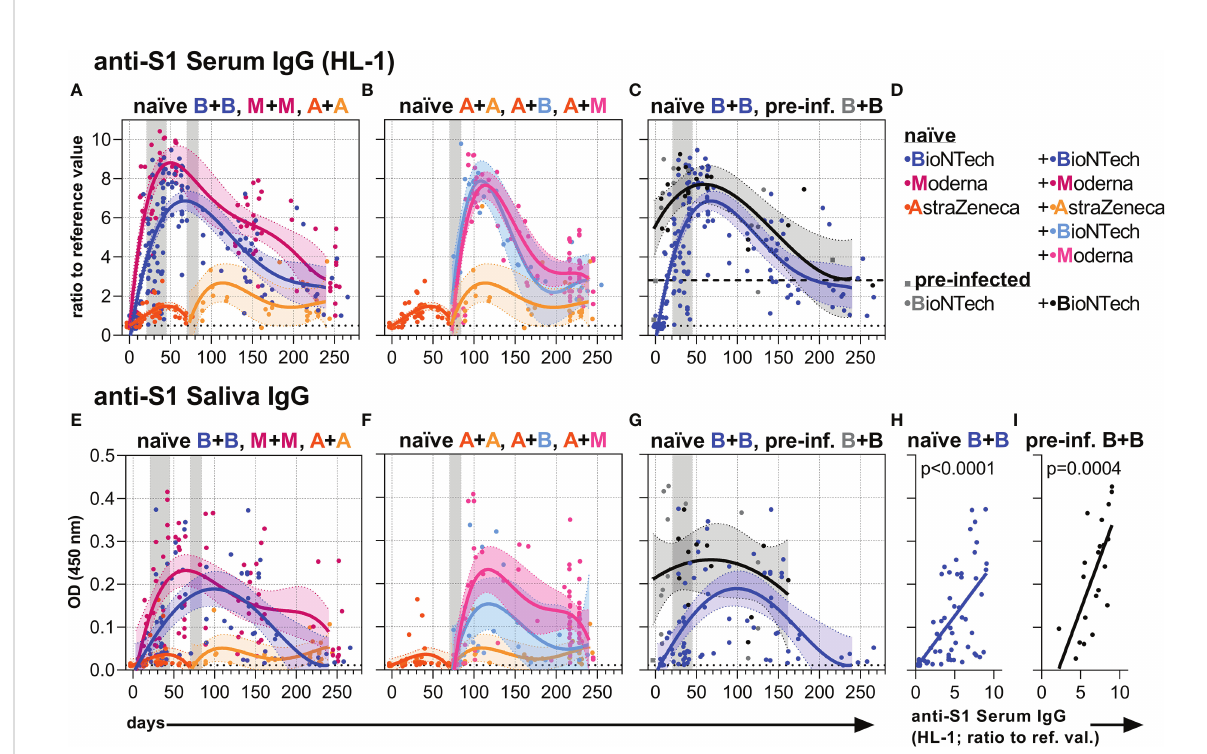
FIGURE 1 Anti-S1 serum and salivary IgG levels. (A-C) Anti-S1 serum IgG (HL-1 ELISA) levels (ratios to reference value) of the indicated six vaccination groups. (D) Color legend of the six study groups. (E – G) Anti-S1 salivary IgG levels (OD 450 nm values) of the indicated six groups. Gray bars: time windows of the second shot after the fi rst shot with an mRNA (between day 21 and 45) or adenovirus-based (between day 70 and 84) vaccine. Dashed ( — (C) ) and dotted ( … ) lines indicate the corresponding average anti-S1 IgG levels of pre-infected individuals without/before vaccination or non-vaccinated healthy (negative) controls, respectively. (H, I) Pearson correlations between anti-S1 serum IgG (HL-1) levels and anti-S1 salivary IgG levels (y-axis as in (E) ) of all paired samples from once and twice BNT162b2-vaccinated naïve and pre-infected individuals. p -values of the indicated correlations are